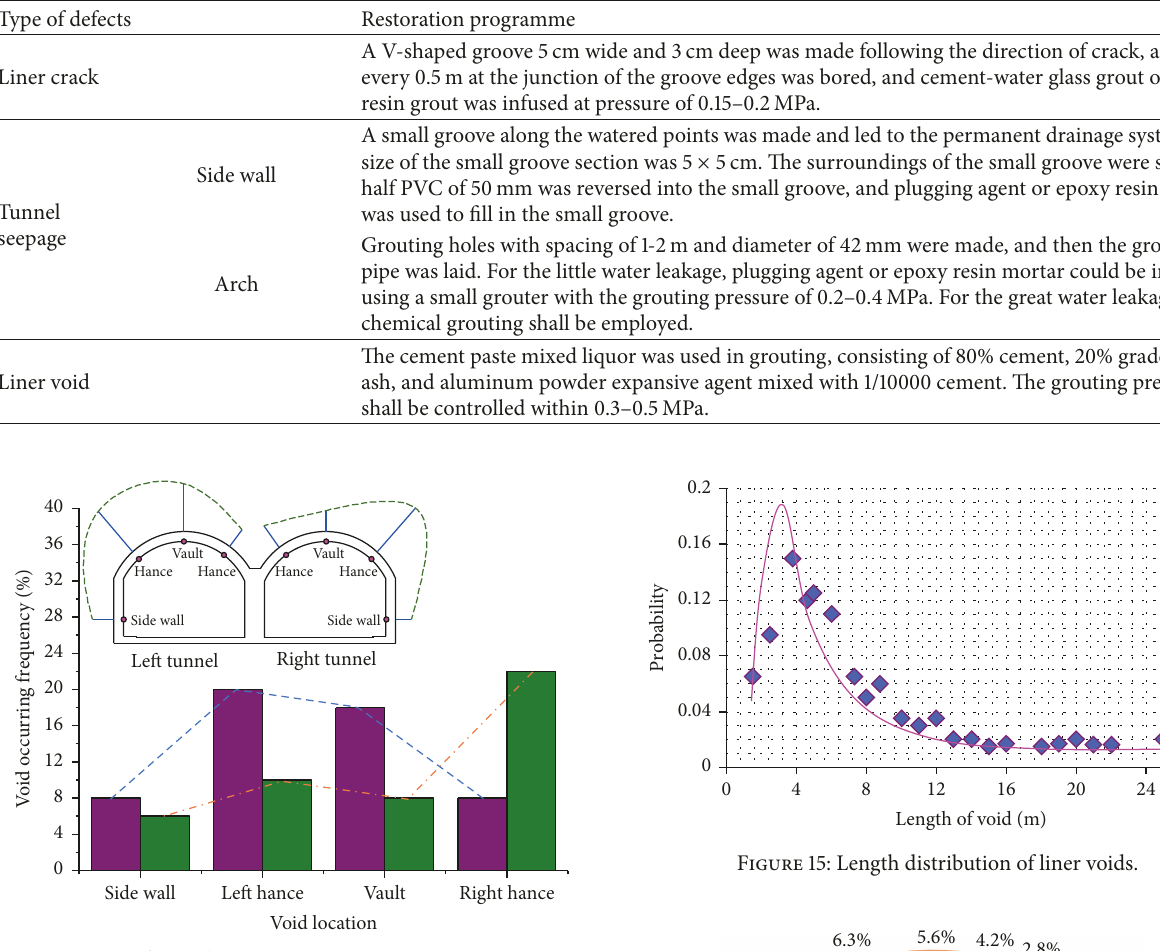
Table 6: Major restoration programme for structural defects of Shitigou tunnel.